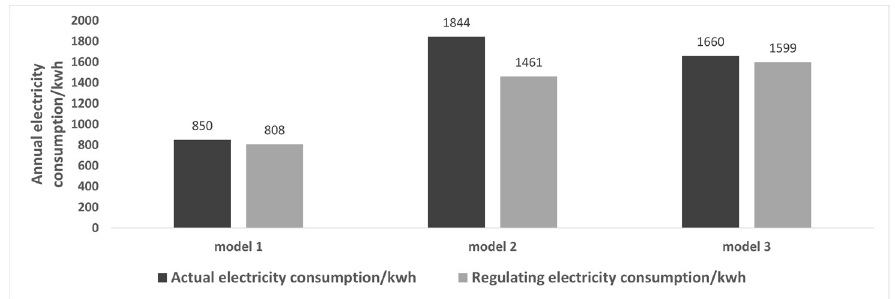
Figure 11. Code and actual annual building electricity consumption rates.